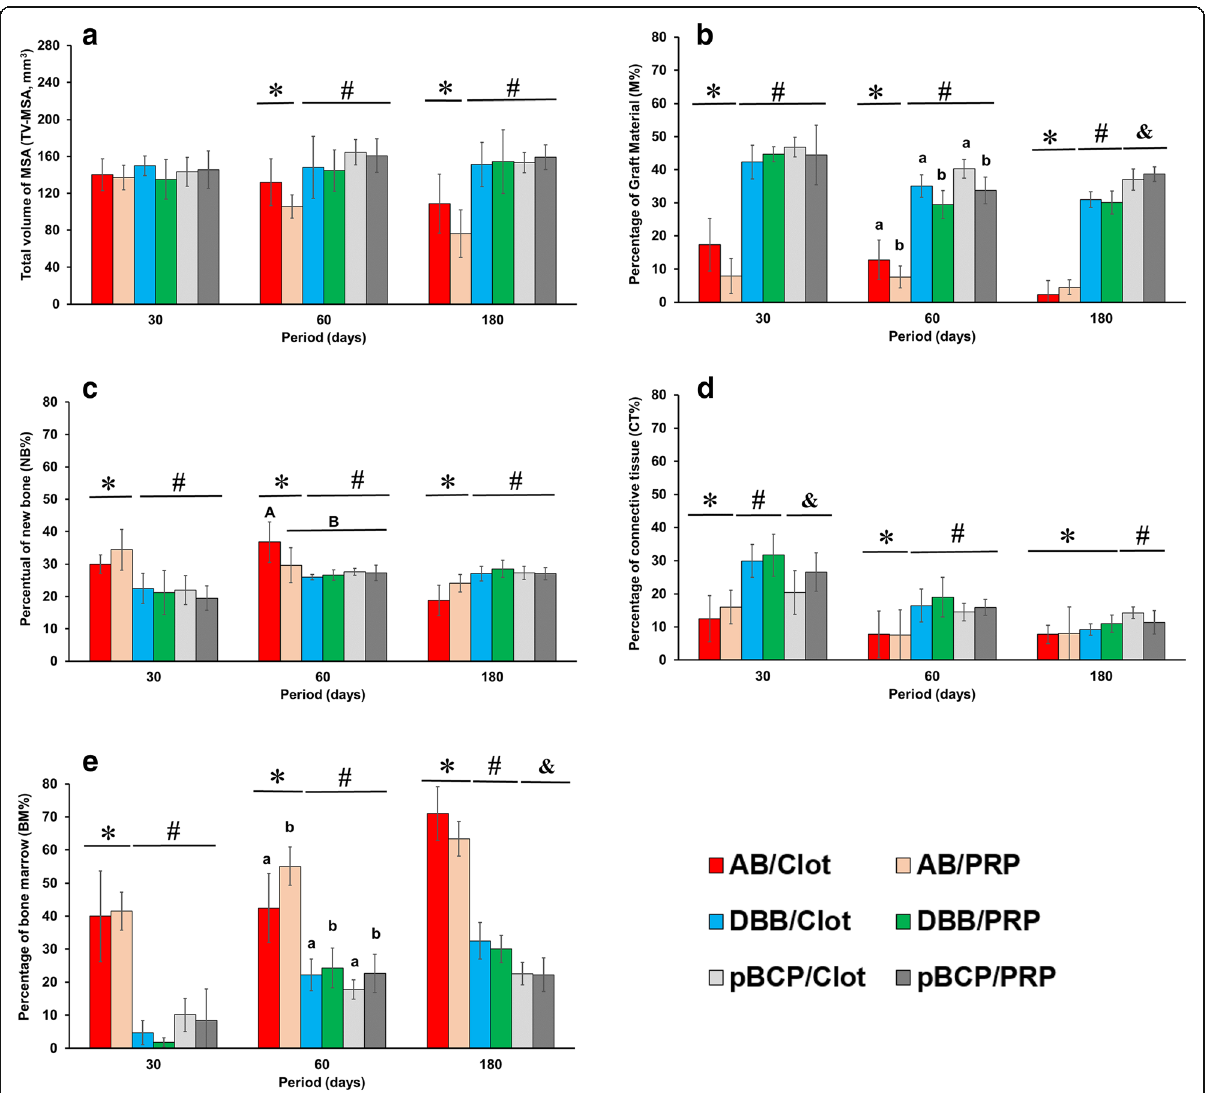
Fig. 6 Graft materials versus treatment. Graphs of TV-MSA ( a ), M% ( b ), NB% ( c ), CT% ( d ), and BM% ( e ) obtained by AB/clot, AB/PRP, DBB/clot, DBB/PRP, pBCP/clot, and pBCP/PRP. Two-way ANOVA, different symbols p < 0.05 for materials/period; different lowercase letters p < 0.05 for treatment/period and different capital letters p < 0.05 among groups (interaction between material and